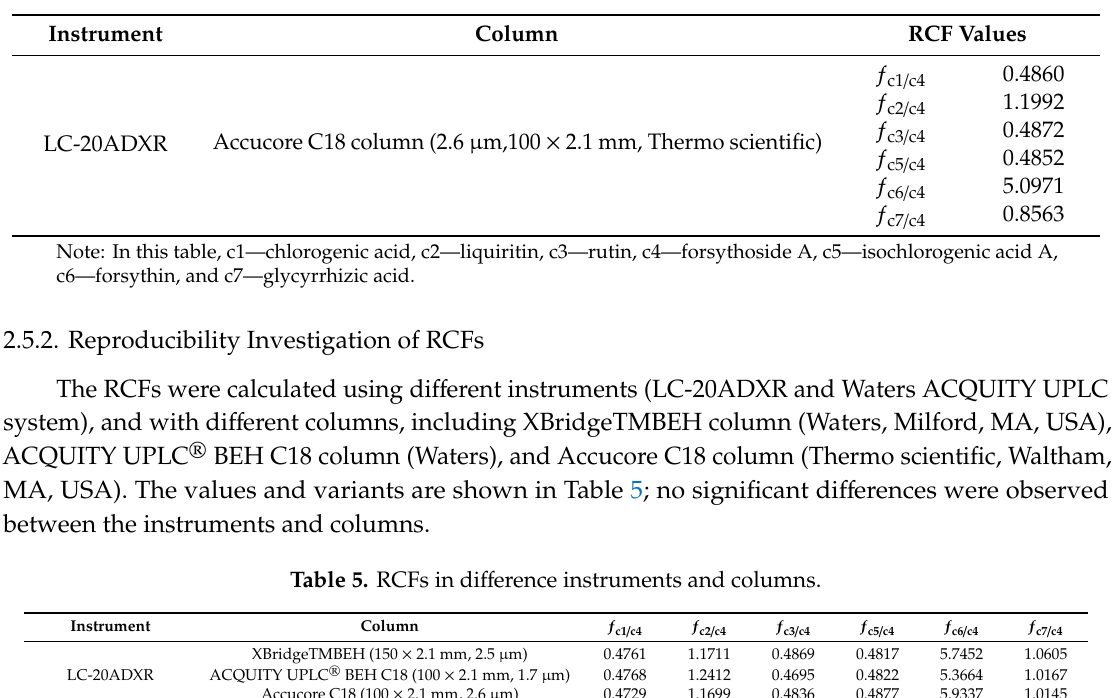
Table 4. Relative correction factors (RCFs) of six compounds against forsythoside A.